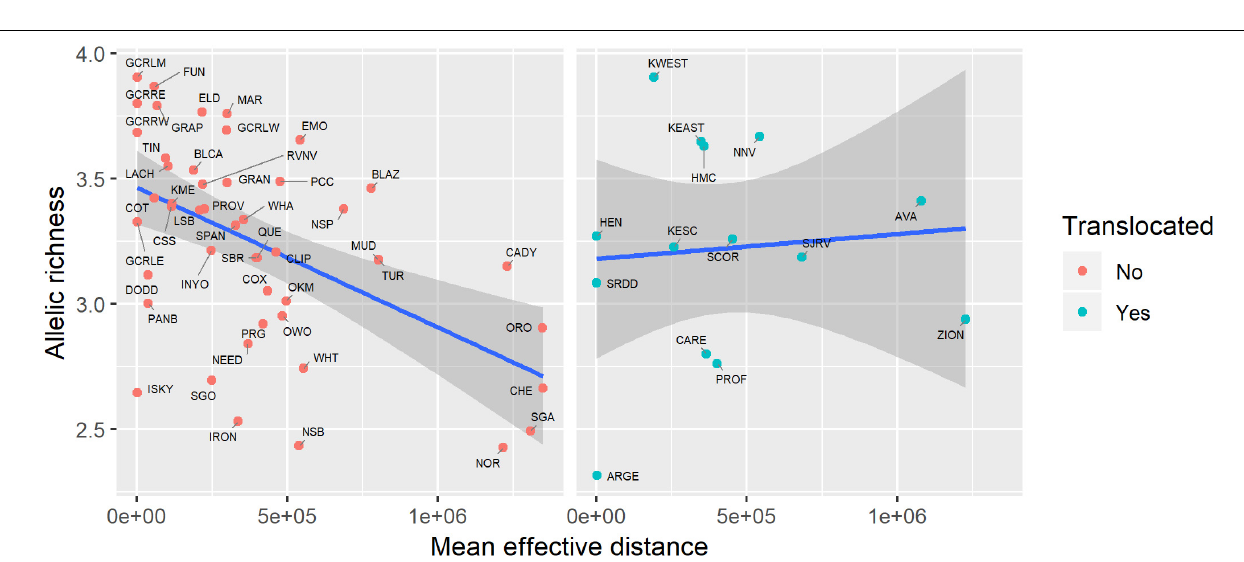
FIGURE 5 | Relationship between genetic diversity (measured as allelic richness) and genetic isolation (measured as mean pairwise F ST with three nearest populations) for native and translocated desert bighorn sheep populations. Blue line and dark gray band show best fit line and 95% confidence interval, respectively, from linear regression model. See Table 1 for full population names.